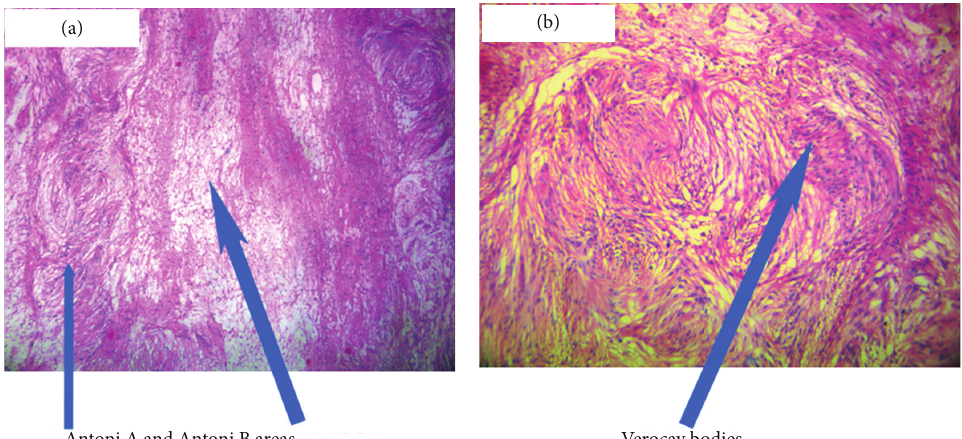
Figure 3: Histopathology of ancient schwannoma showing spindle cells arranged in dense Antoni A bearing Verocay bodies and loose Antoni B